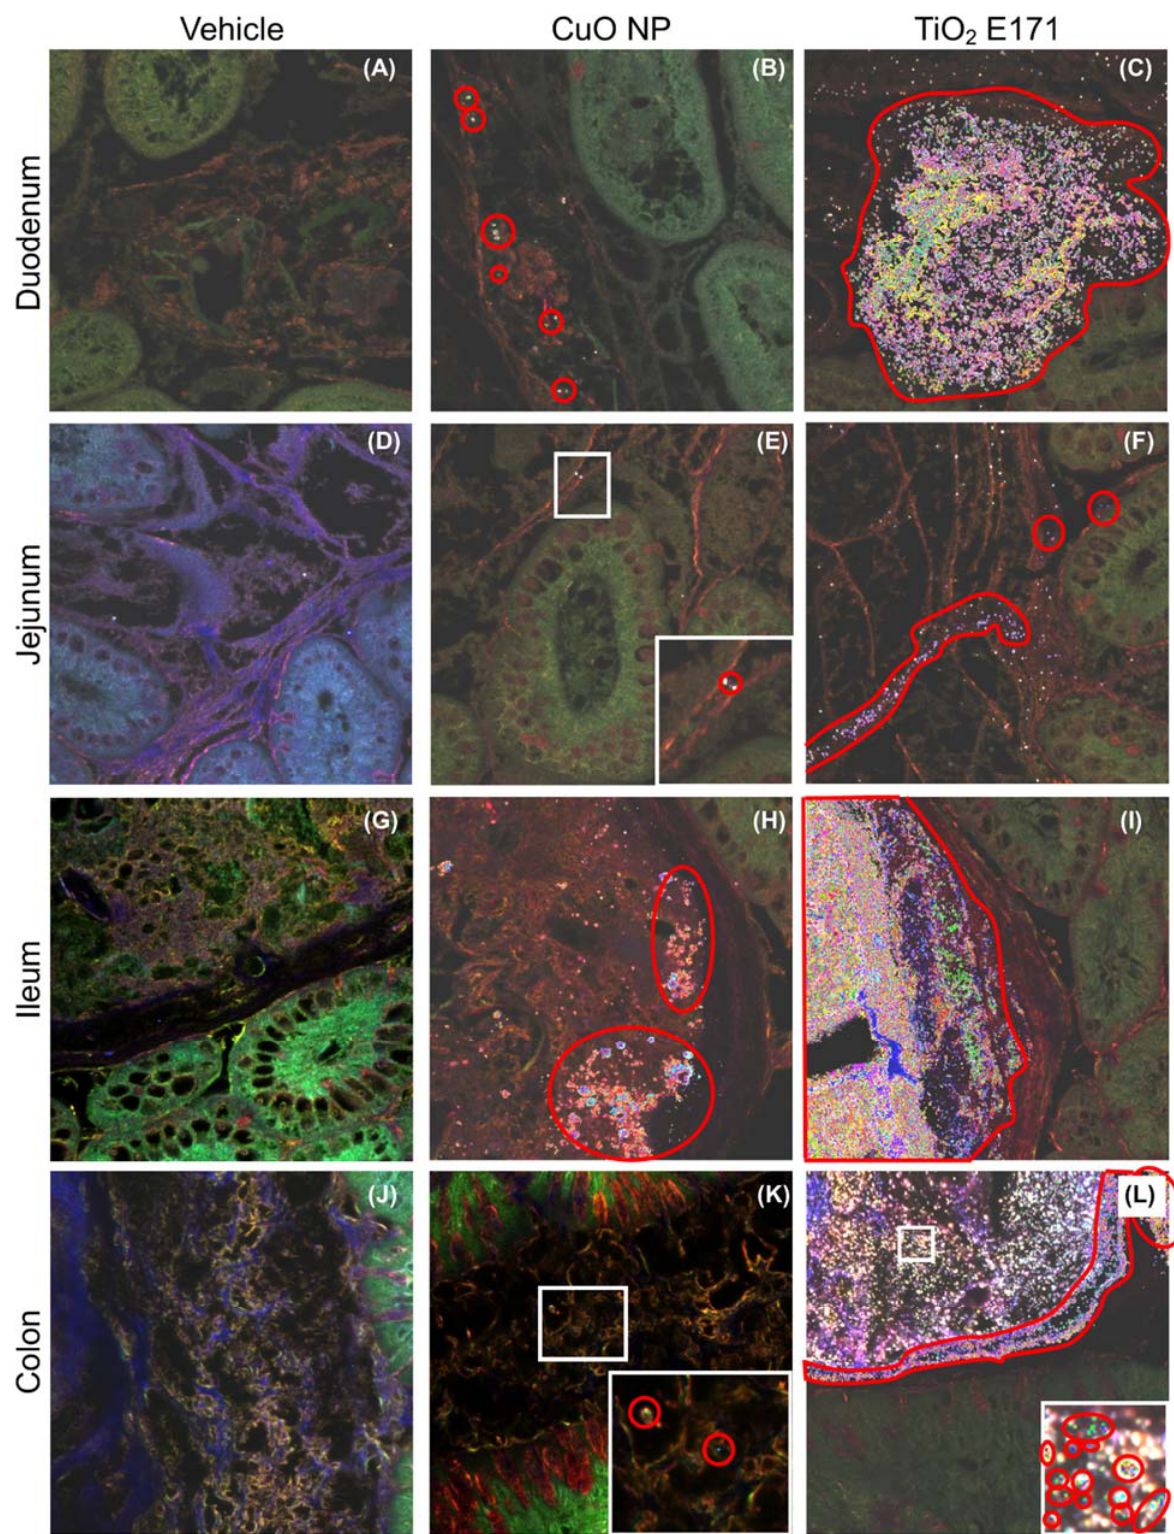
Figure 2. Enhanced darkfield microscopy (EDM) and hyperspectral imaging (HSI) of intestinal cross sections of AB-PAS stained duodenum ( A – C ), jejunum ( D – F ), ileum ( G – I ), and colon ( J – L ) tissue for rat pups dosed between PND 7–10 with vehicle control ( A , D , G , J ), CuO NP ( B , E , H , K ), or TiO 2 E171 ( C , F , I , L ). Mapped NPs (individual pixels) are shown with different colors, and areas with mapped NPs are highlighted with red circles and polygons.